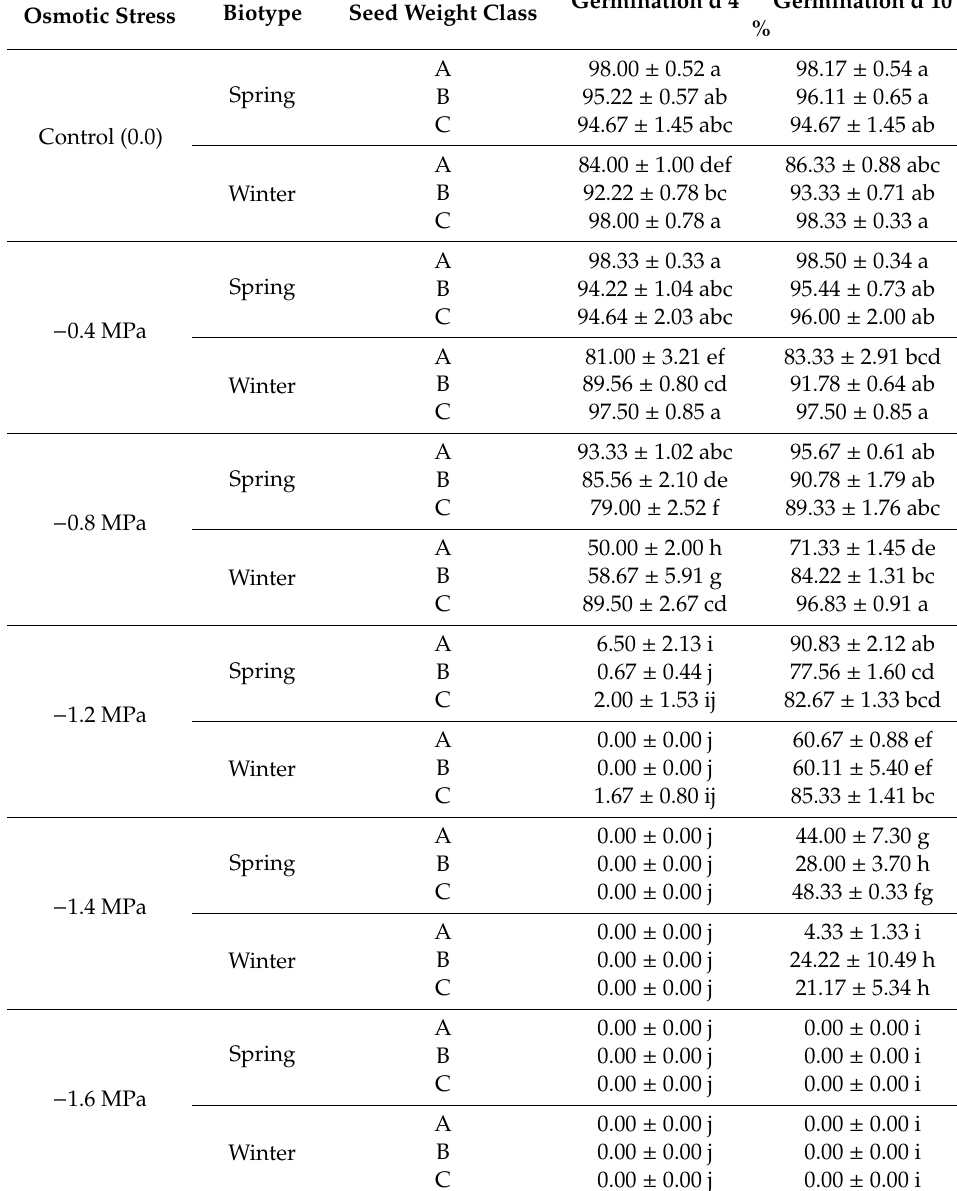
Table 4. Camelina germination percentage (%), surveyed at 4 and 10 days after stress imposition, as a ff ected by the interaction osmotic stress level (0 vs. − 0.4 vs. − 0.8 vs. − 1.2 vs. − 1.4 vs. − 1.6 MPa)